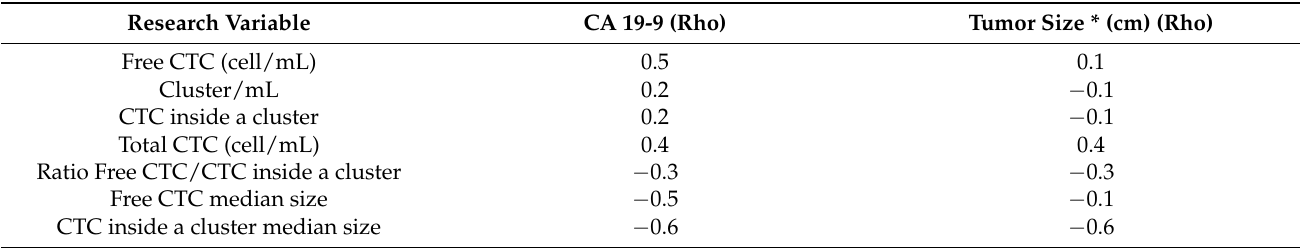
Table 4. Tumor and CA 19-9 preoperatively evaluated by CTC characteristics with Spearman correlation coefficient (Rho) (CVC measurements).